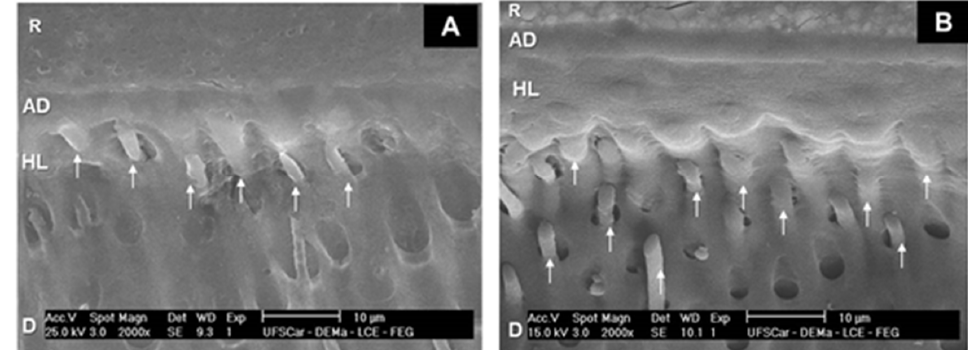
Figure 3. SEM micrographs of Group 3. ( A ) 2000×. Note the uniformity of hybrid layer (HL) at the dentin (D)/adhesive (AD)/composite resin (R) interface, with resinous tags (thin arrows). ( B ) 2000×. Hybrid layer (HL) at the dentin (D)/adhesive (AD)/composite resin (R) interface, and resinous tags (thin arrows).